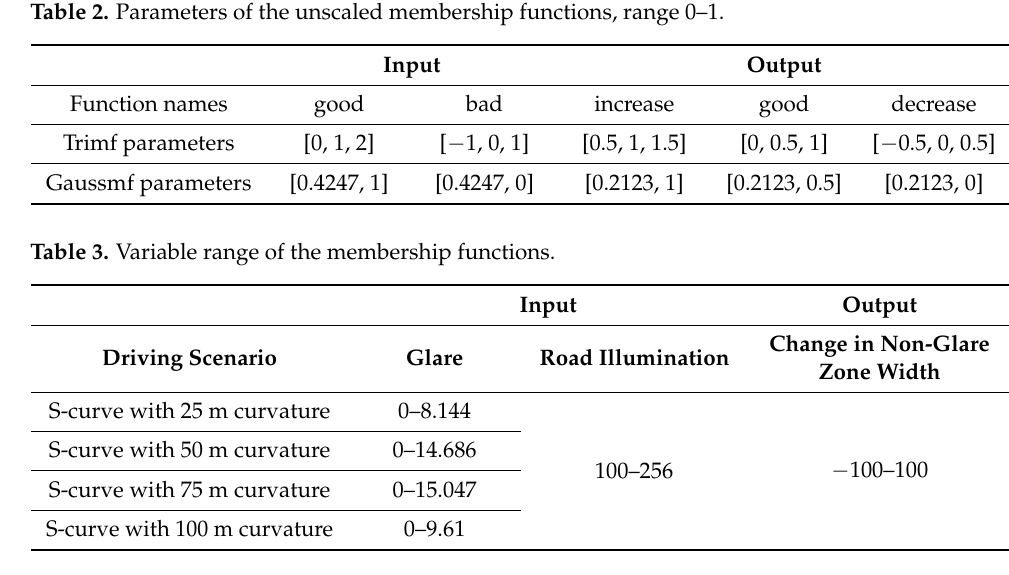
Figure 13. Membership function of fuzzy logic controller: ( a ) road illumination input triangular membership function in Trial 1; ( b ) change in non-glare zone width output triangular membership function in Trial 1; ( c ) road illumination input Gaussian membership function in Trial 2; ( d ) change in non-glare zone width output Gaussian membership function in Trial 1. Table 2. Parameters of the unscaled membership functions, range 0–1.